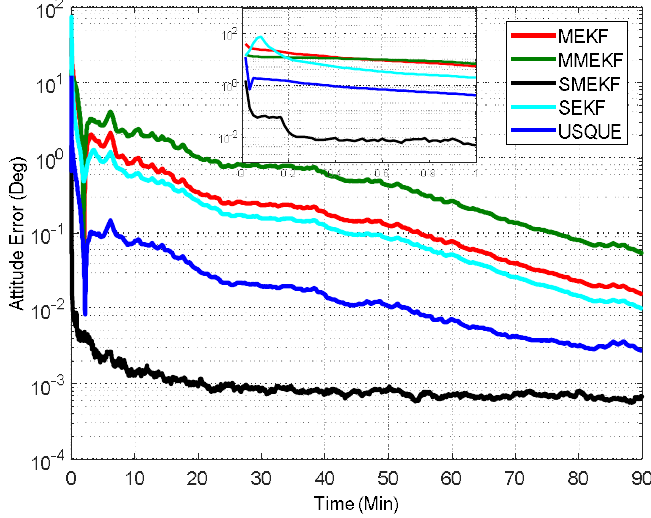
Figure 5. Norm of attitude estimation errors (case 2).